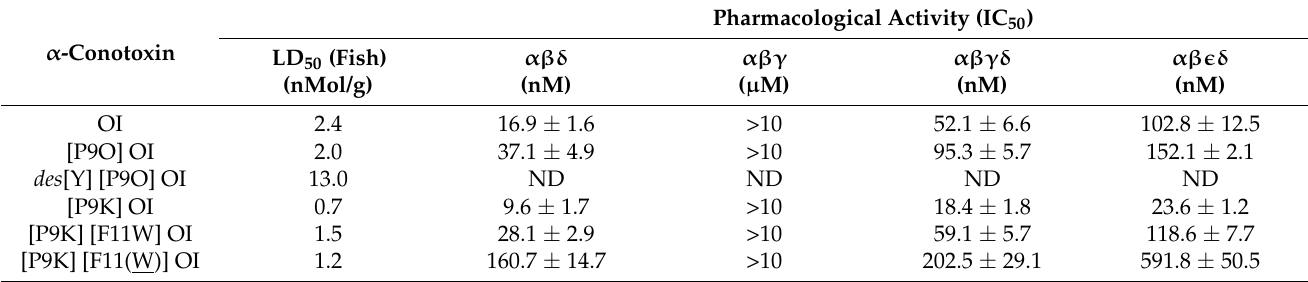
Table 2. Pharmacological Activity of α -conotoxin OI and analogs.